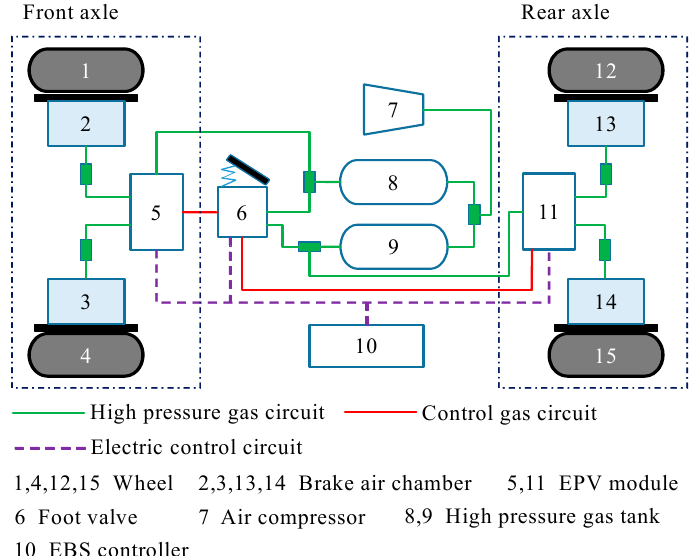
Figure 2. EBS structural layout and schematic diagram based on the EPV module.